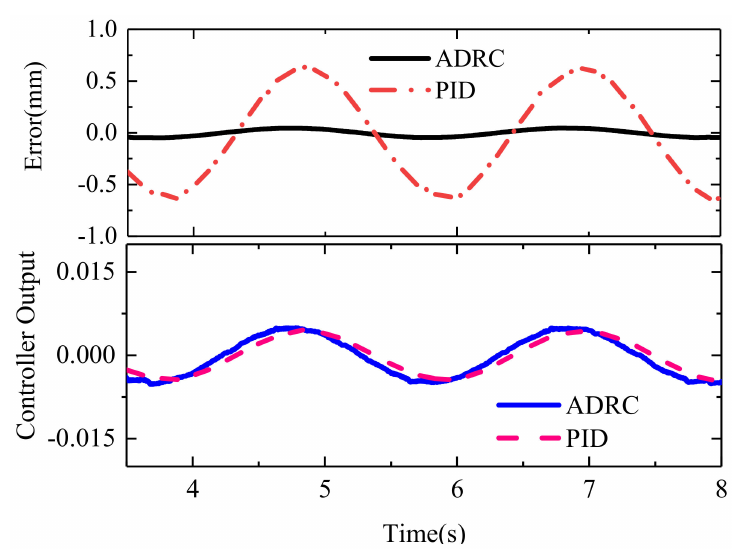
Figure 15. Error and controller